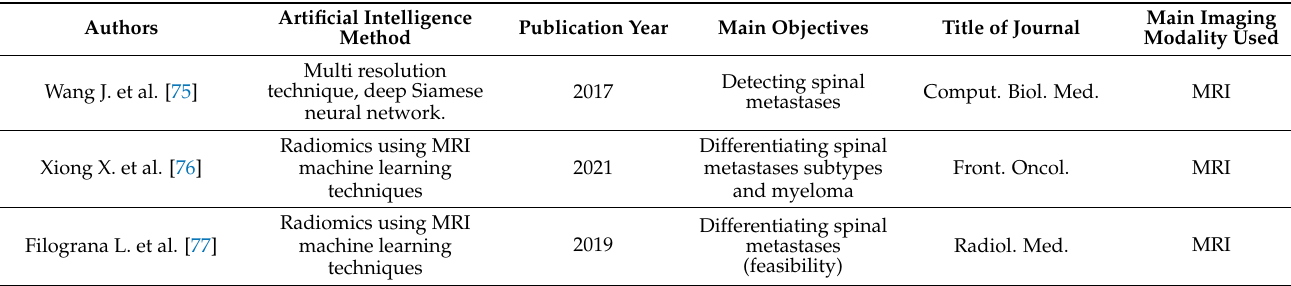
Table 1. Key characteristics of the selected